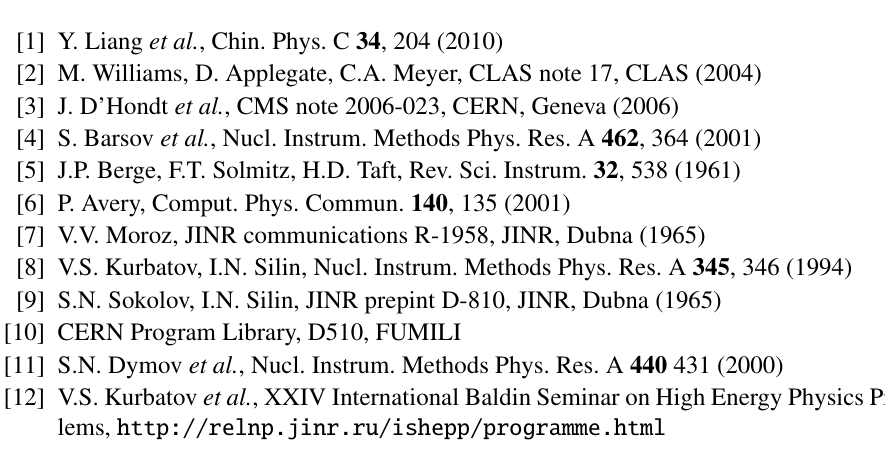
Figure 2. Errors of reconstructed proton momentum in polar coordinates ( | p cm of mass system for the pp → pp reaction at ANKE, simulated for T beam = 700 MeV either with (a) or without (b) kinematic fitting. The error bars show the average di ff erence between the momentum components used as the simulation input and the ones obtained by the detector simulation program during the